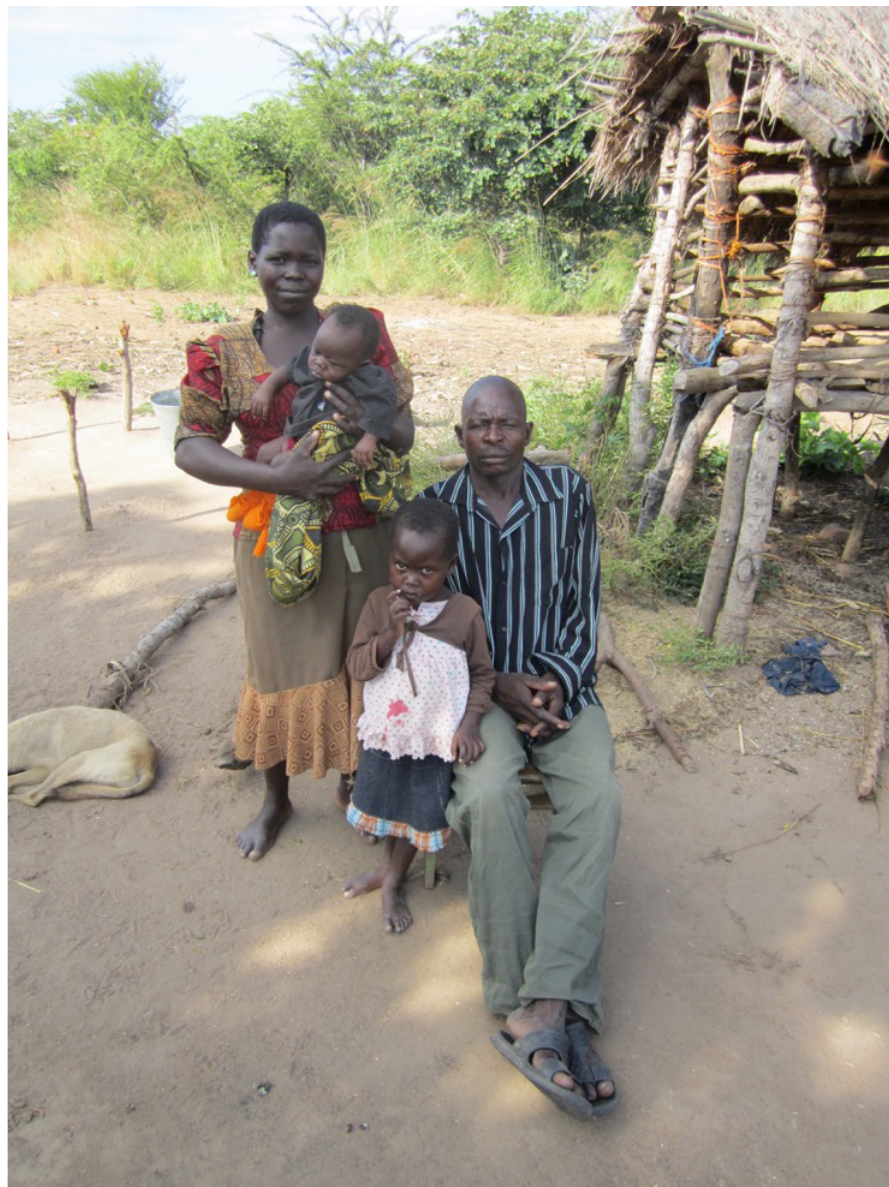
Photograph 8: Farmer (44) with his second wife and their